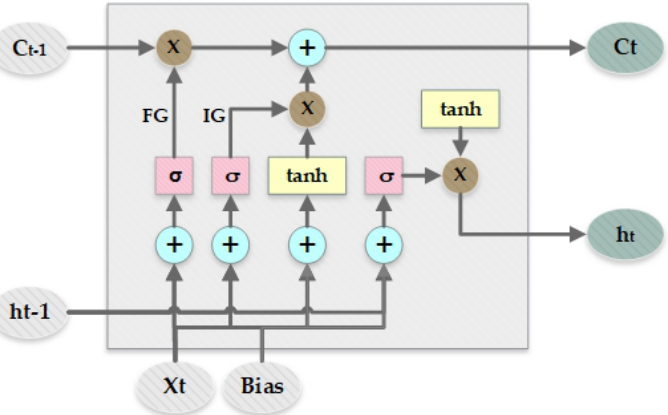
Figure 5. Layout of long short-term memory